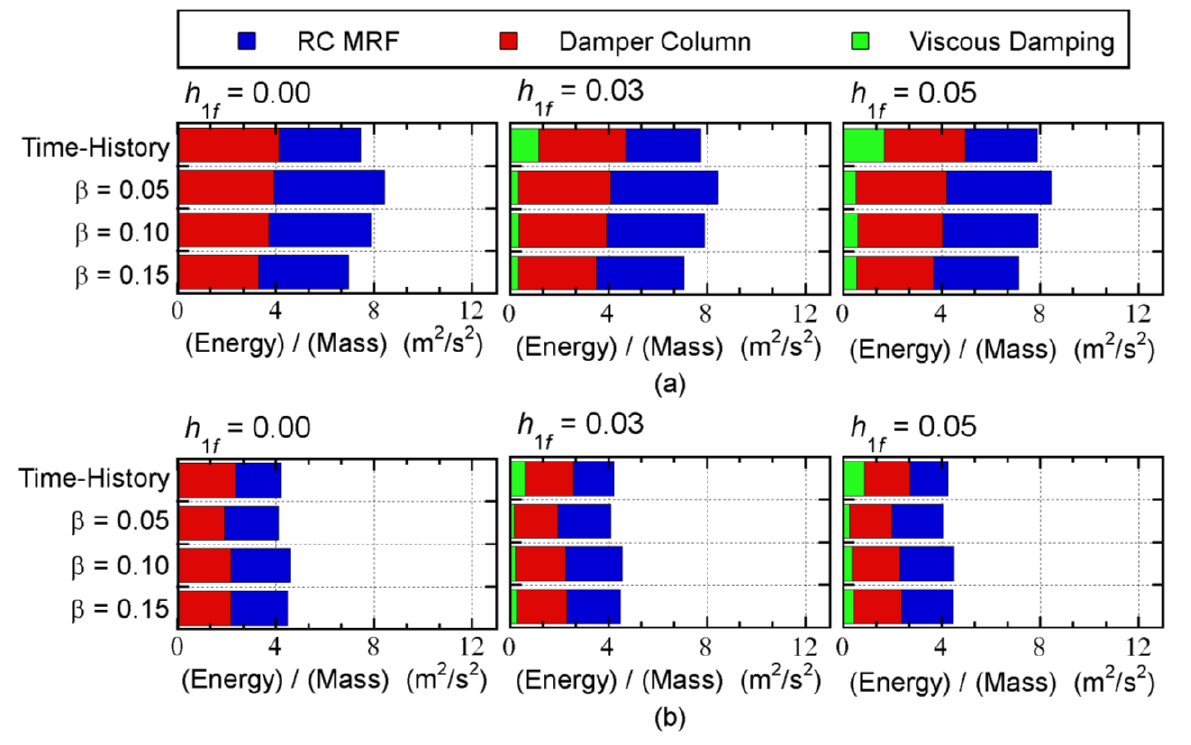
Figure 11. Prediction of the energy demand of the overall building (16-story model): ( a ) Art-L series; ( b ) Art-S series.